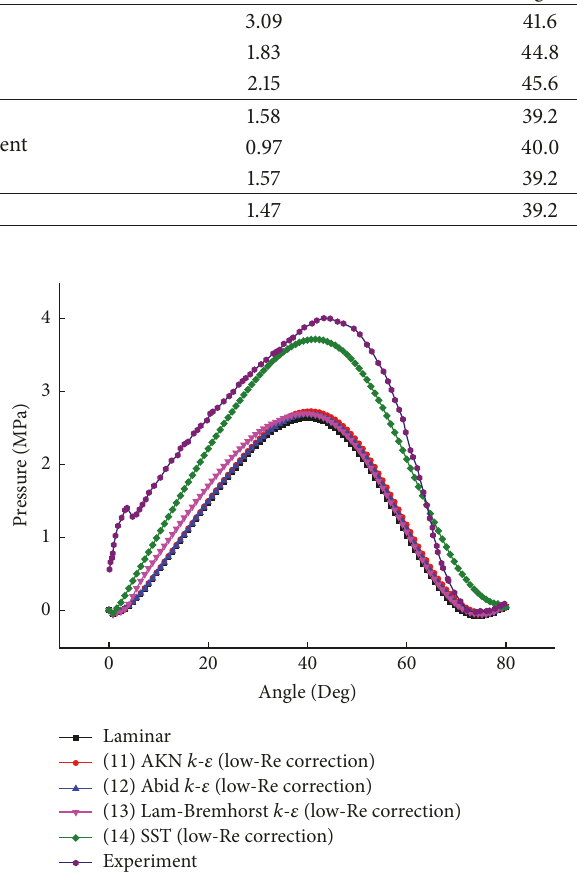
Figure 8: Comparison between the experimental pressure profile at 3000 rpm and under 180 kN and the simulated pressure profiles with the fixed film geometry in pad-side center line for the group of the transition turbulence models.